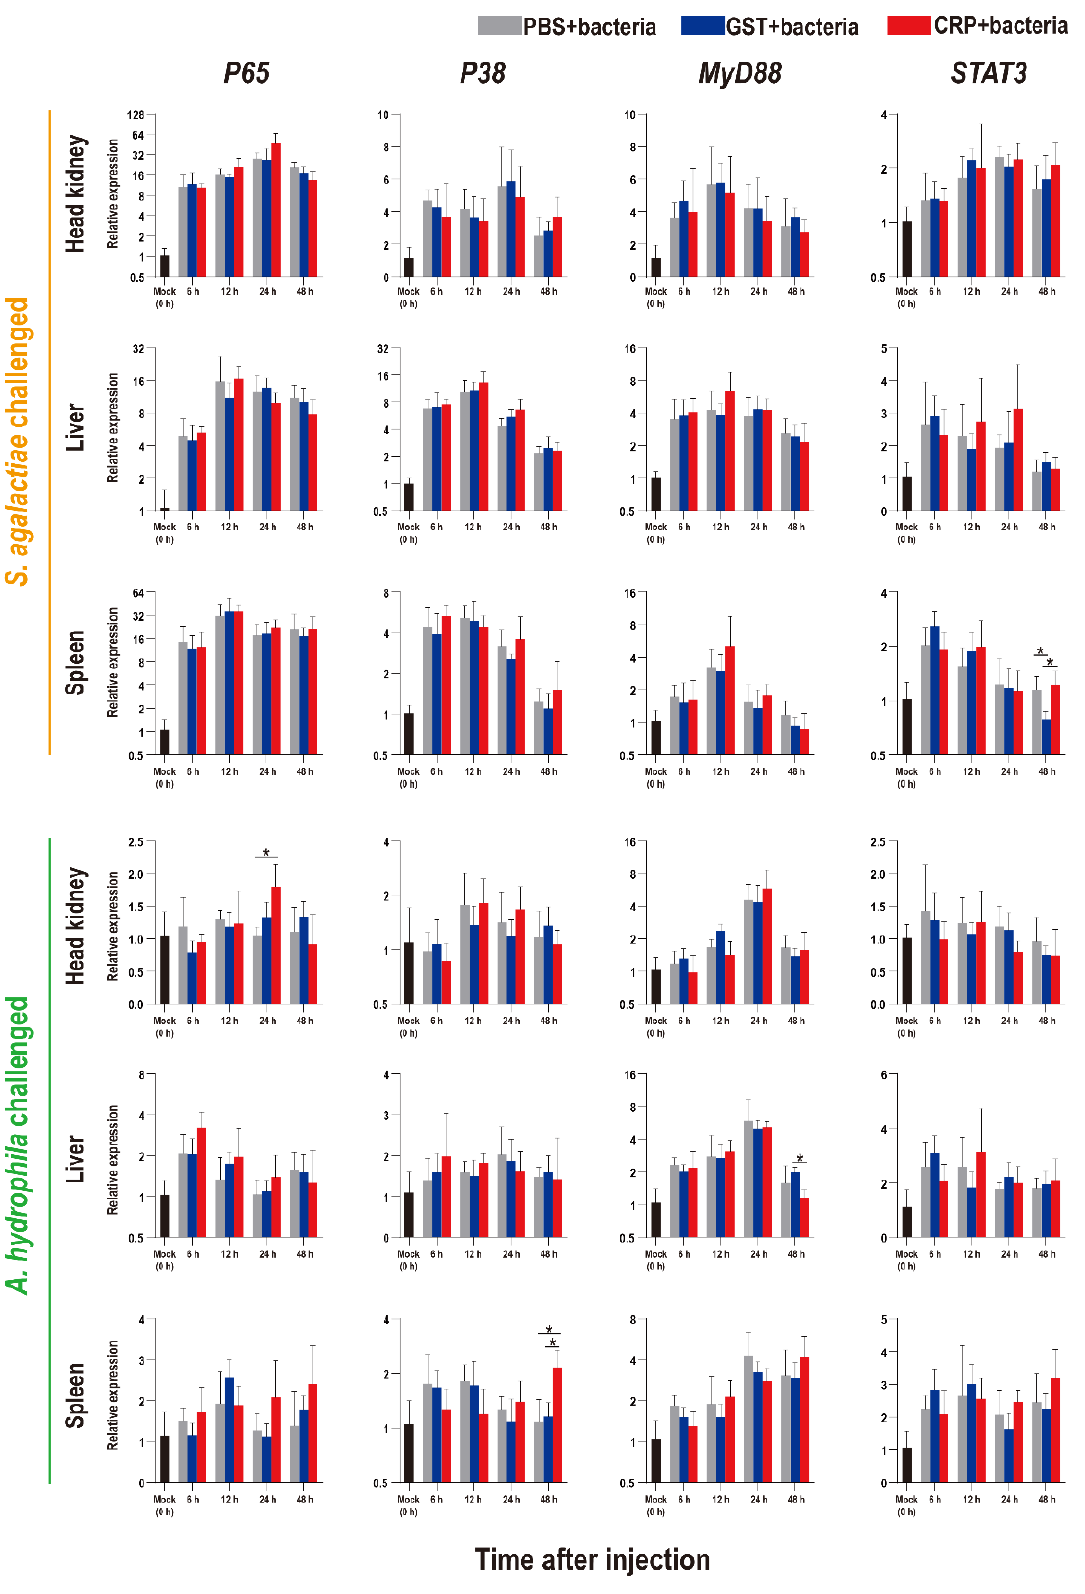
Figure 7. Expression patterns of key genes of four immune-related pathways as assessed via qRT-PCR at different time points post S. agalactiae and A. hydrophila infection. All values are the mean ± SD; n = 3. Significant difference is indicated by asterisks ( p < 0.05).